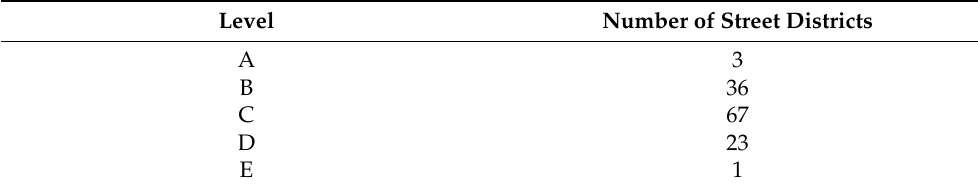
Table 3. High-risk heat space